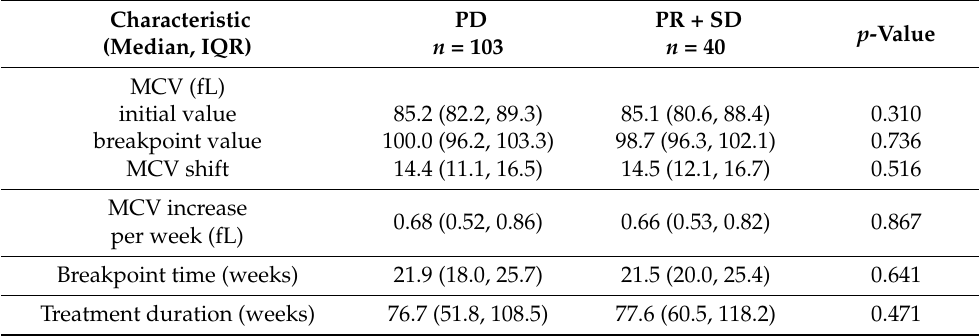
Table 4. Observed parameters of MCV time-courses and relation to patient clinical condition at the moment of treatment discontinuation in the group of full